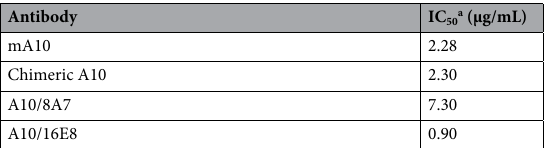
Table 2. The half maximal inhibitory concentration (IC 50 ) of mA10, chimeric A10, A10/8A7, and A10/16E8 obtained by ADAMTS13 inhibition assay. a The IC 50 values were estimated by using R version 3.6.2